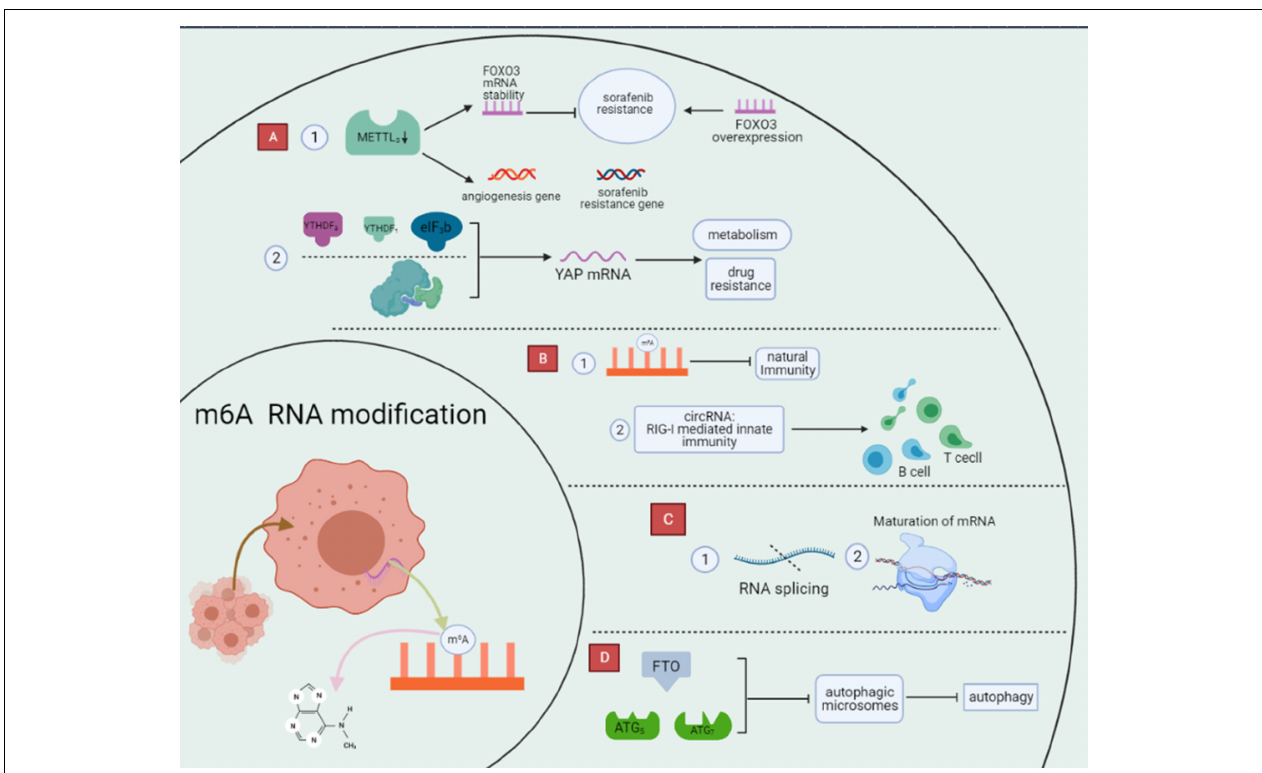
FIGURE 3 | Regulation of biological function of m6A RNA modification. m6A modifications are the most abundant modifications within RNA and can profoundly influence the process of cancer development by regulating biological functions such as drug resistance, immune metabolism, and autophagy through a variety